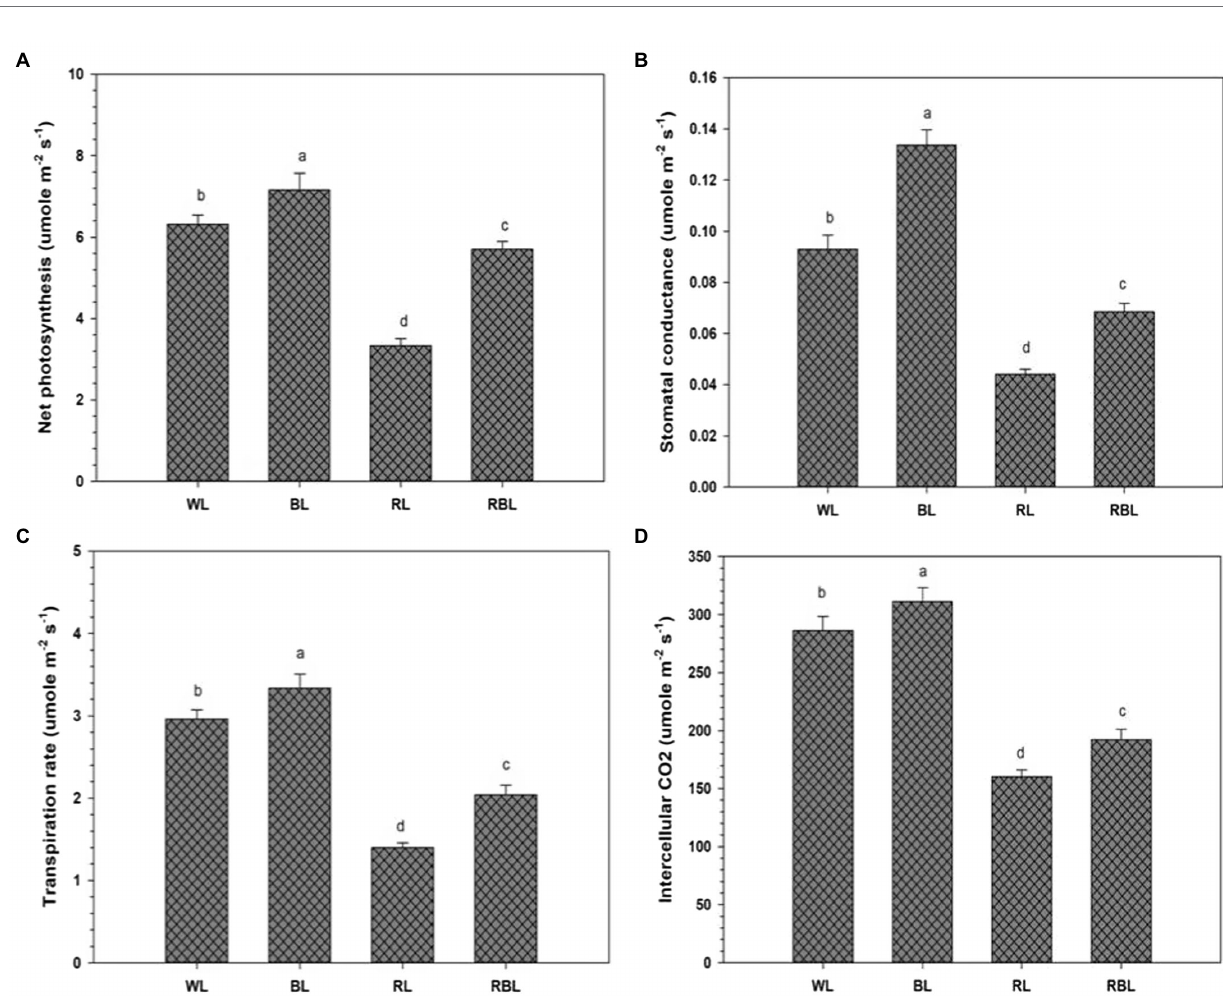
FIGURE 2 | Effects of differential light quality on net photosynthesis (A) , stomatal conductance (B) , transpiration rate (C) , and intercellular CO 2 concentration (D) in industrial hemp grown under different color light-emitting diodes. Bars indicated the mean ± SD ( n = 3). Different letters on bars indicated significant difference between treatments at p ≤ 0.05. Different abbreviations used in the figure are as follows: WL, white light LED (control); BL, blue light LED, RL, red light LED; RBL, 50% red and 50% blue Light